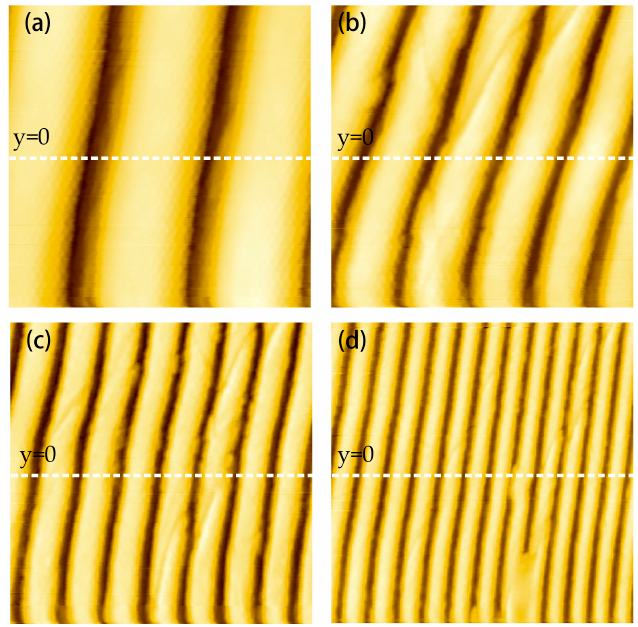
Figure 11. Scanned images of a DVD disc sample: ( a ) Scan range 2 μ m × 2 μ m; ( b ) scan range 3.3 μ m × 3.3 μ m; ( c ) scan range 5.3 μ m × 5.3 μ m; ( d ) scan range 8 × 8 μ m.